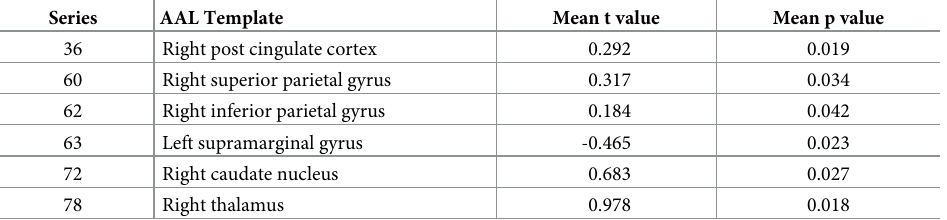
Table 4. Brain regions with significant differences in local efficiency between the CCH and control groups (cor- rected p < .05).